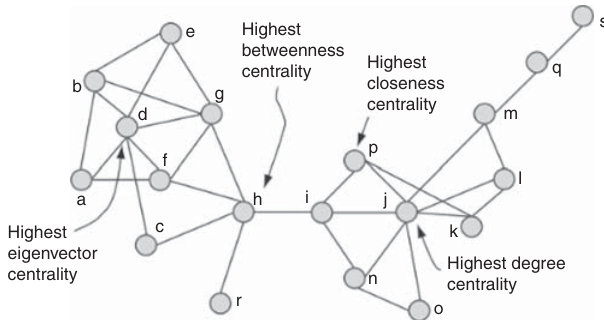
Figure 1. Different measures of centrality applied over an example